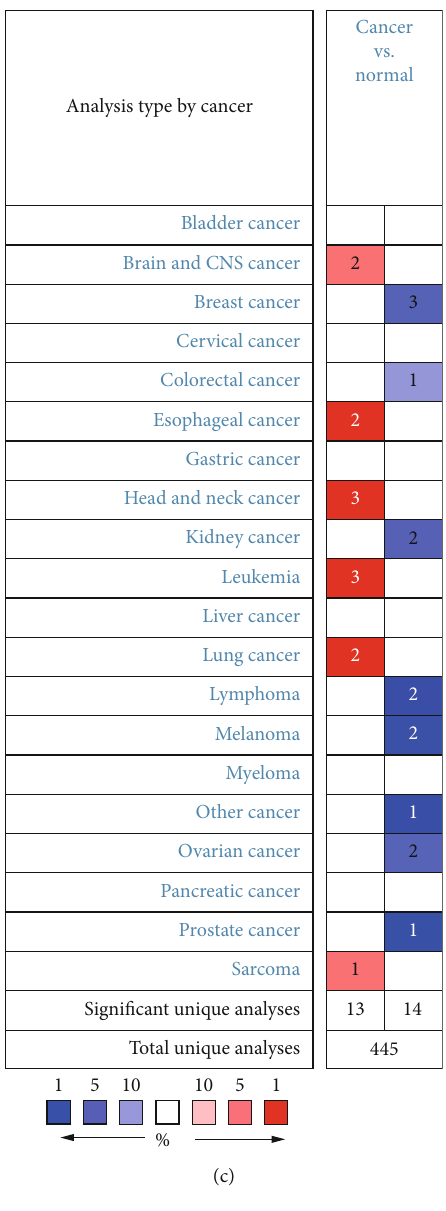
Figure 1: (a) Expression of NT5E across TCGA cancers. The results showed that NT5E was highly expressed in HNSCC compared with normal tissues ( P < 0 : 05 ). (b) Di ff erential expression of NT5E in multiple cancers in GEPIA database. The red tumor type represents the upregulated expression of NT5E, the green tumor type represents the downregulated expression of NT5E, and the black tumor type represents the di ff erence of no statistical signi fi cance. We can see that NT5E is upregulated in HNSCC. (c) Overview of NT5E in multiple cancers in Oncomine database. Red represents upregulation, blue represents downregulation, and the numbers in the fi gure represent “ fold change. ” We can see that NT5E expression is upregulated in HNSCC, with fold change of